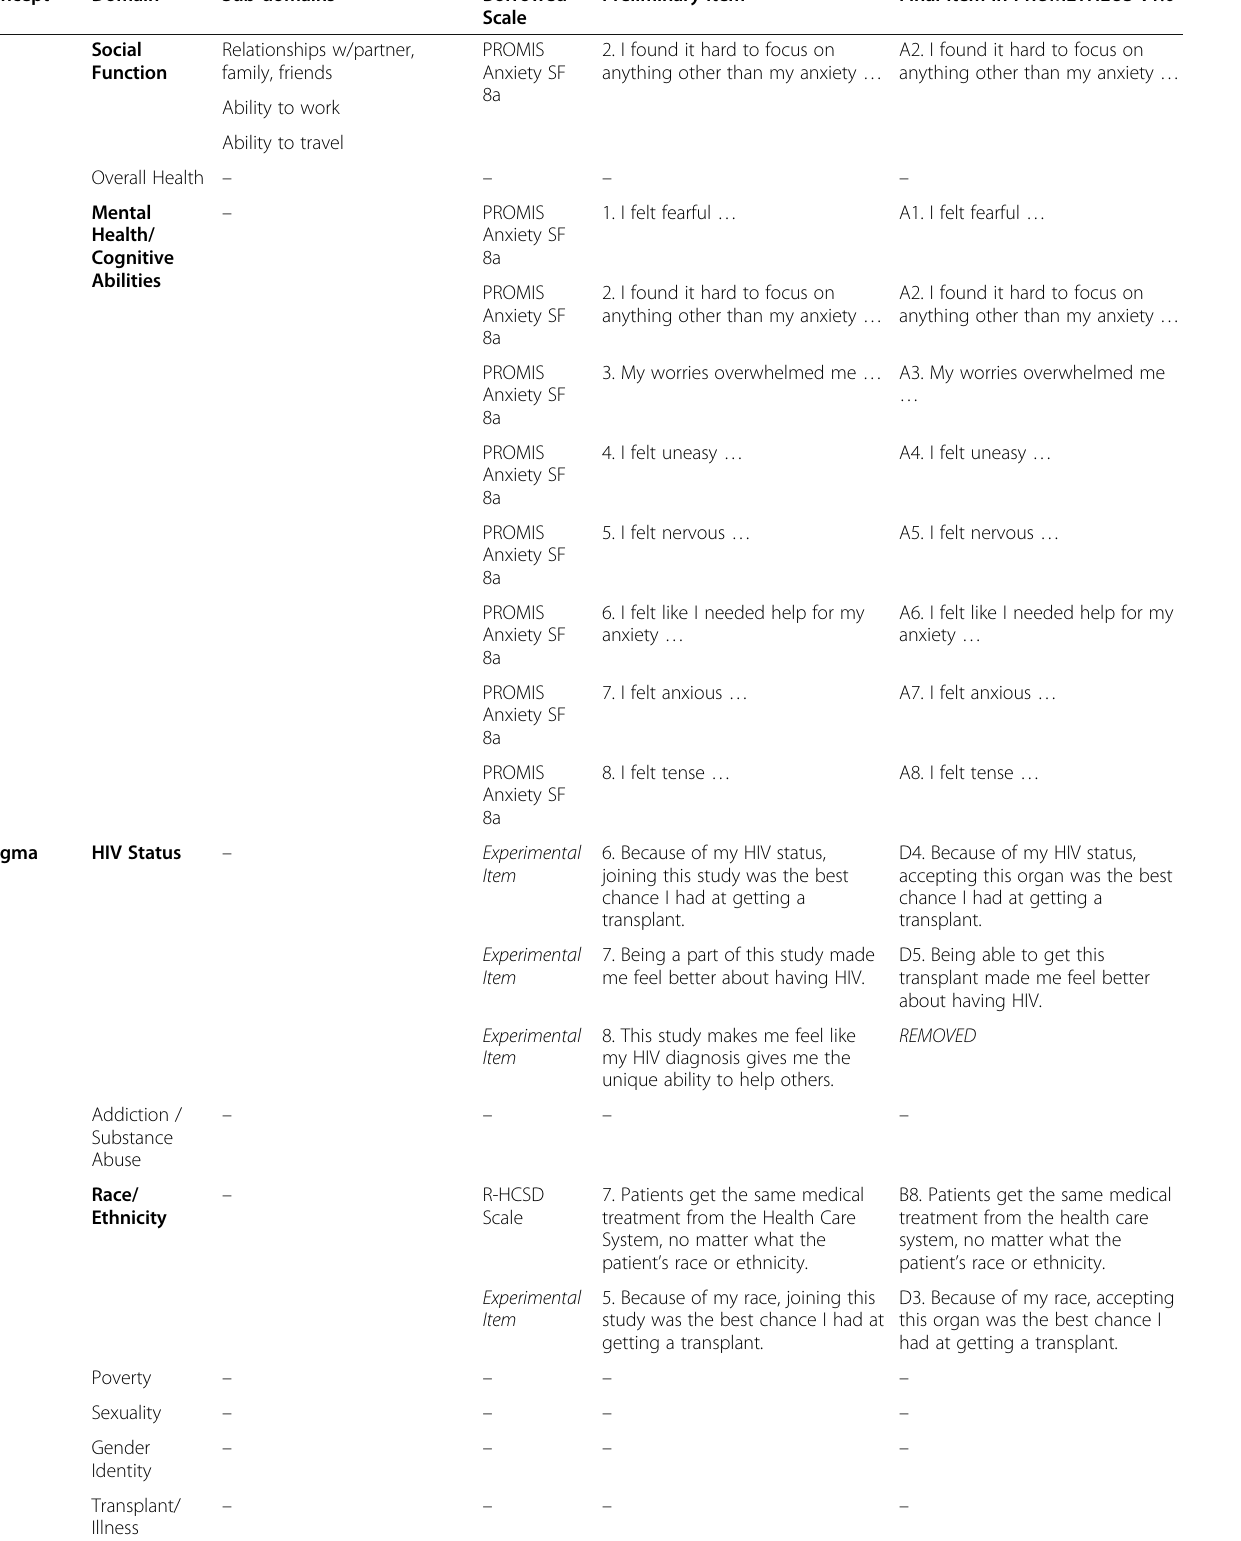
Table 2 PROMETHEUS concepts and domains with items (Continued)